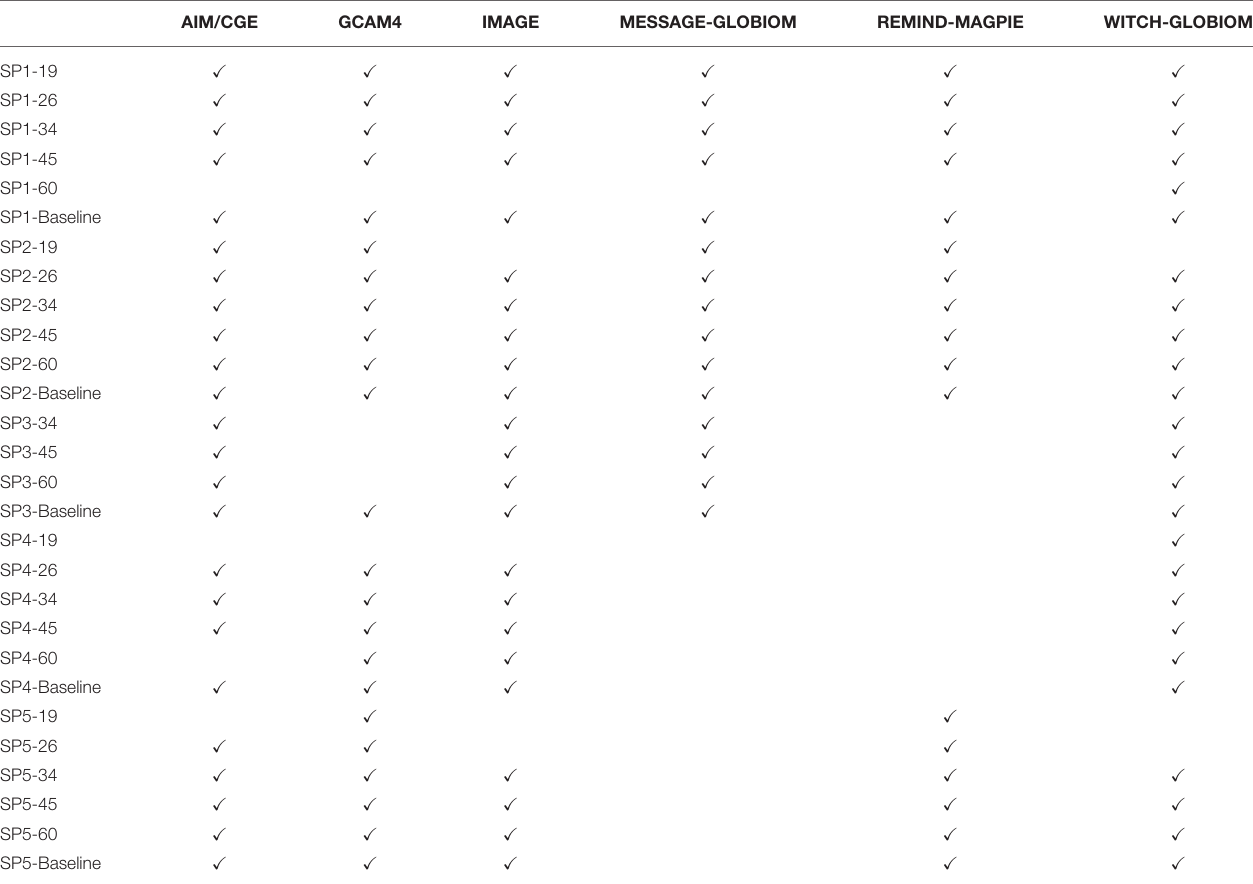
TABLE 2 | The Shared Socioeconomic Pathways (SSPs) and integrated assessment models (IAMs) that form the 127 emission scenarios shown in Figure 1 . AIM/CGE GCAM4 IMAGE MESSAGE-GLOBIOM REMIND-MAGPIE